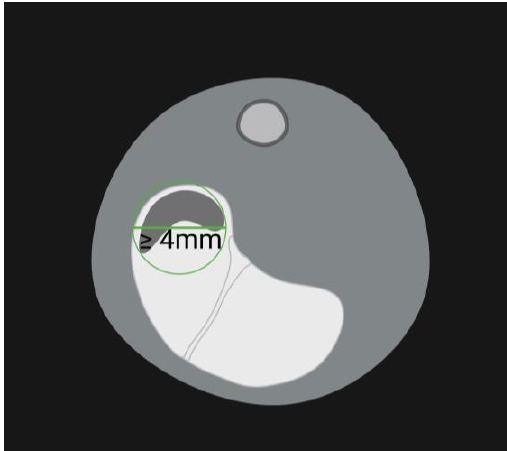
Figure 4. Schematic evaluation of the maximum diameter of a pharmacobezoar in forestomach. ROI: green circle; green horizontal line = maximum diameter.